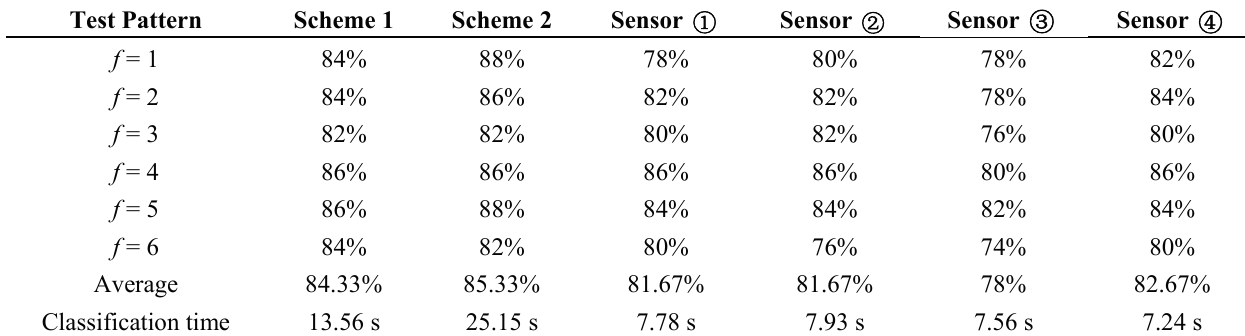
Table 4. Classification accuracy of classifiers based on vibration